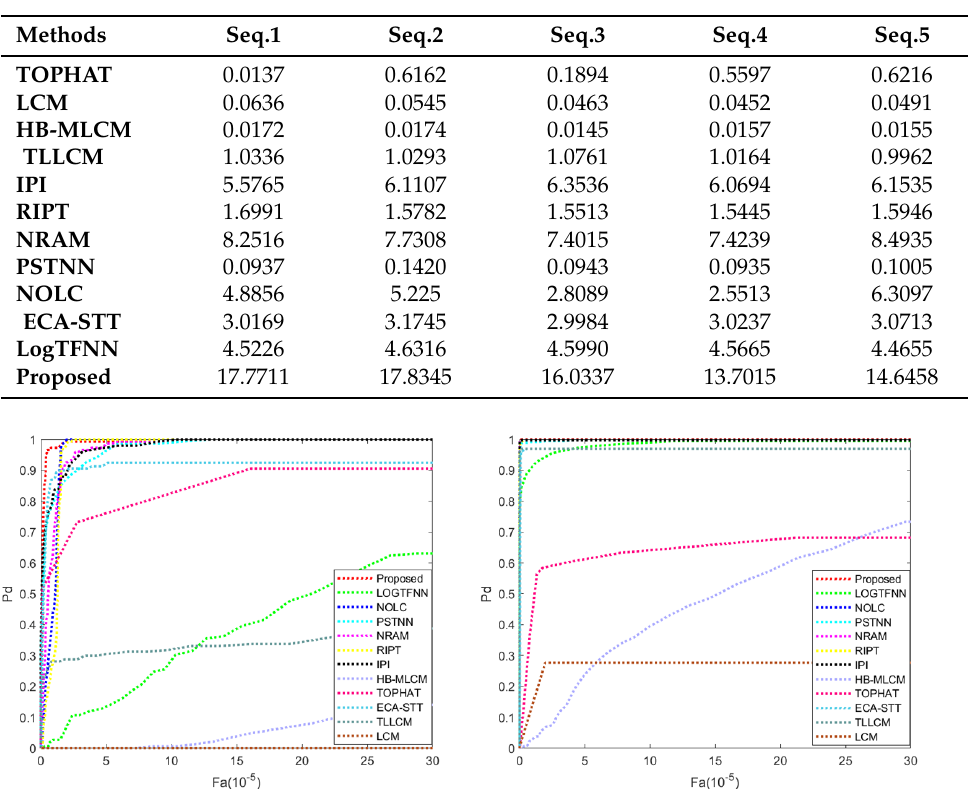
Table 7. Computation time of different methods.